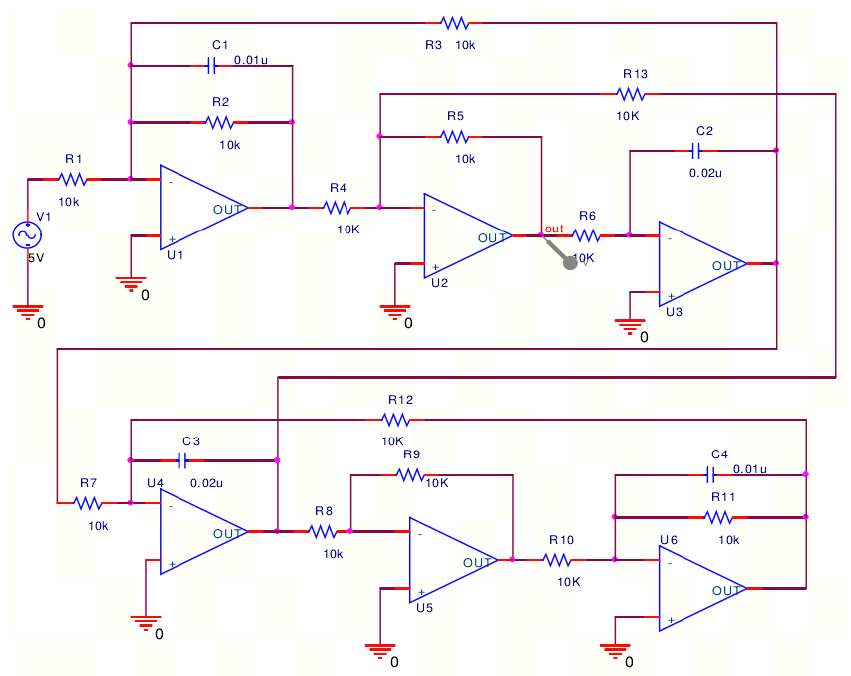
Figure 2. Diagram of Leapfrog circuit.